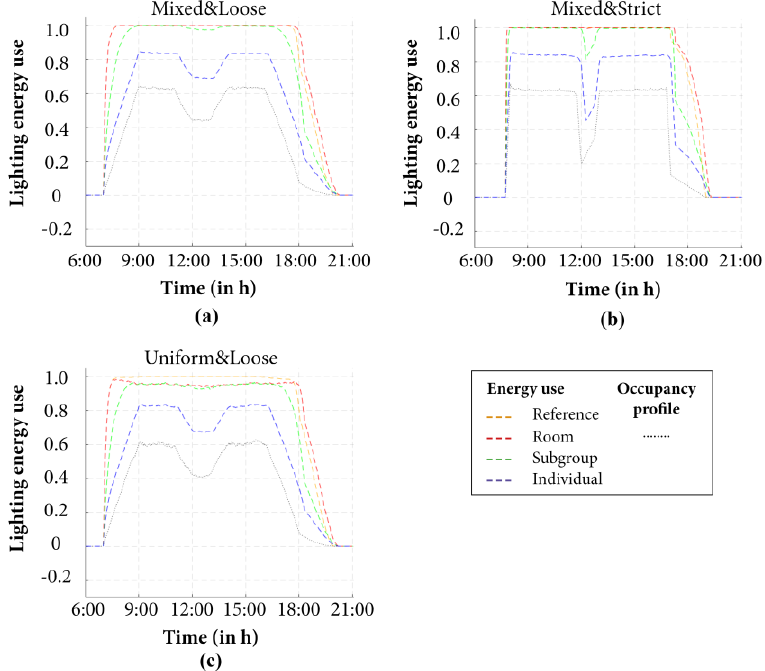
Figure 11. Energy use over the day for the three control strategies (reference case = yellow, room control = red, subgroup control = green, individual control = purple), as well as the average occupancy profile (in grey) for three example office cases: ( a ) Mixed&Loose; ( b ) Mixed&Strict; and ( c ) Uniform&Loose.